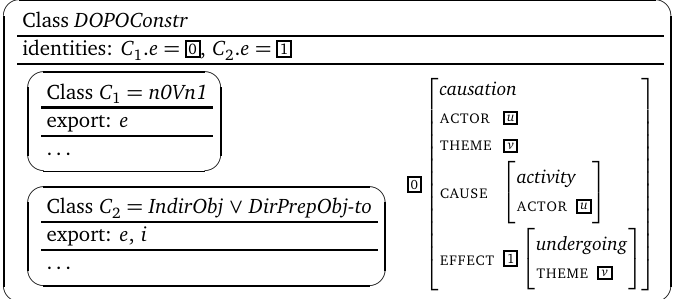
Figure 35: MG class for the alternation between DO and PO